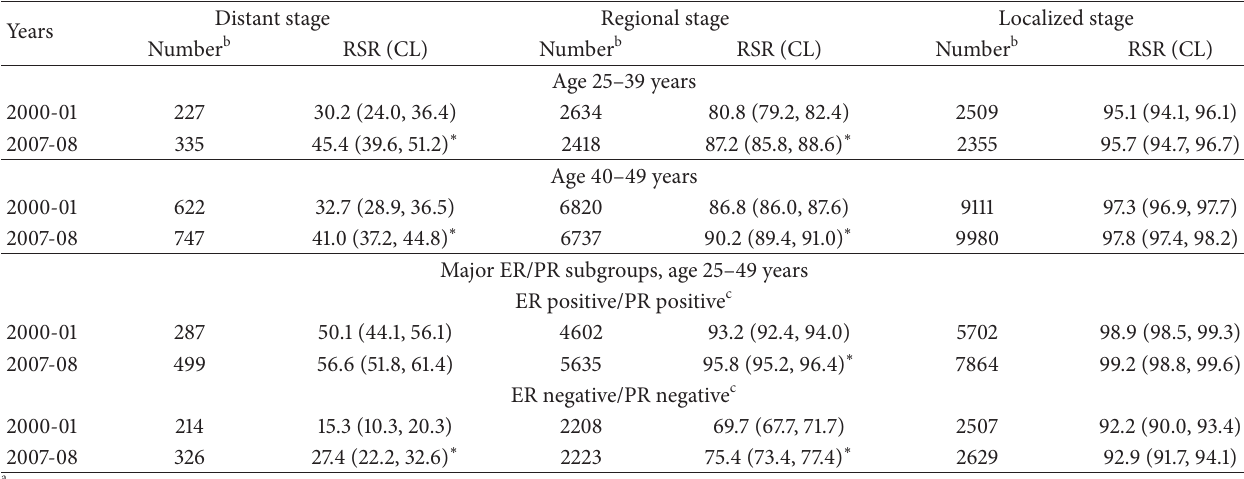
Table 3: Three-year relative survival rate (RSR) for women diagnosed at age < 50 years with invasive breast cancer in SEER registries for selected years of diagnosis by summary stage at diagnosis a